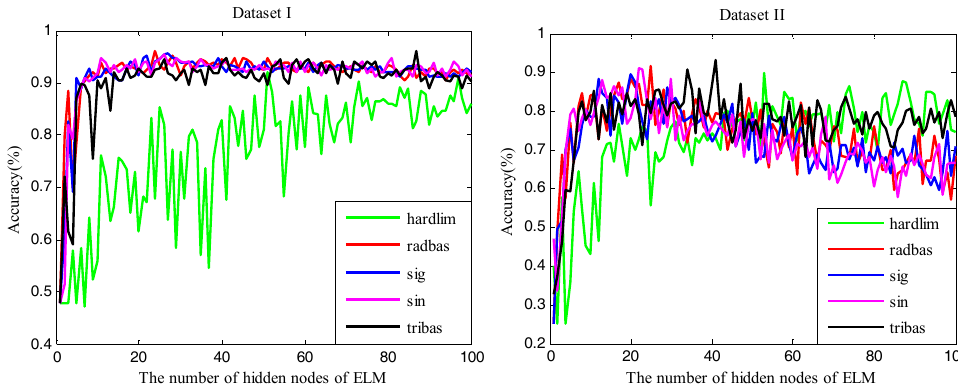
Figure 2. The classification accuracy of ELM in terms of 1–100 hidden nodes. The different colors of lines represent different activation functions. (Note: ELM represents the kernel extreme learning machine).